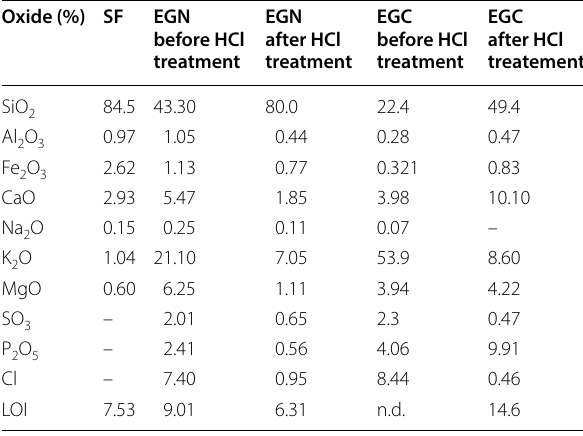
Table 1 Chemical composition of the pozzolans.